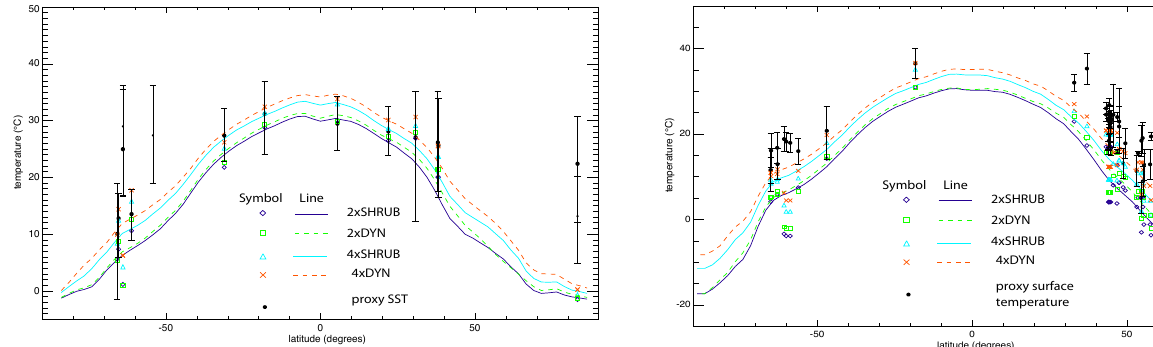
Fig. 5. As Fig. 4 but for zonal annual mean surface air temperatures. Data set from Huber and Caballero (2011), Pross et al. (2012) and Wolfe et al.